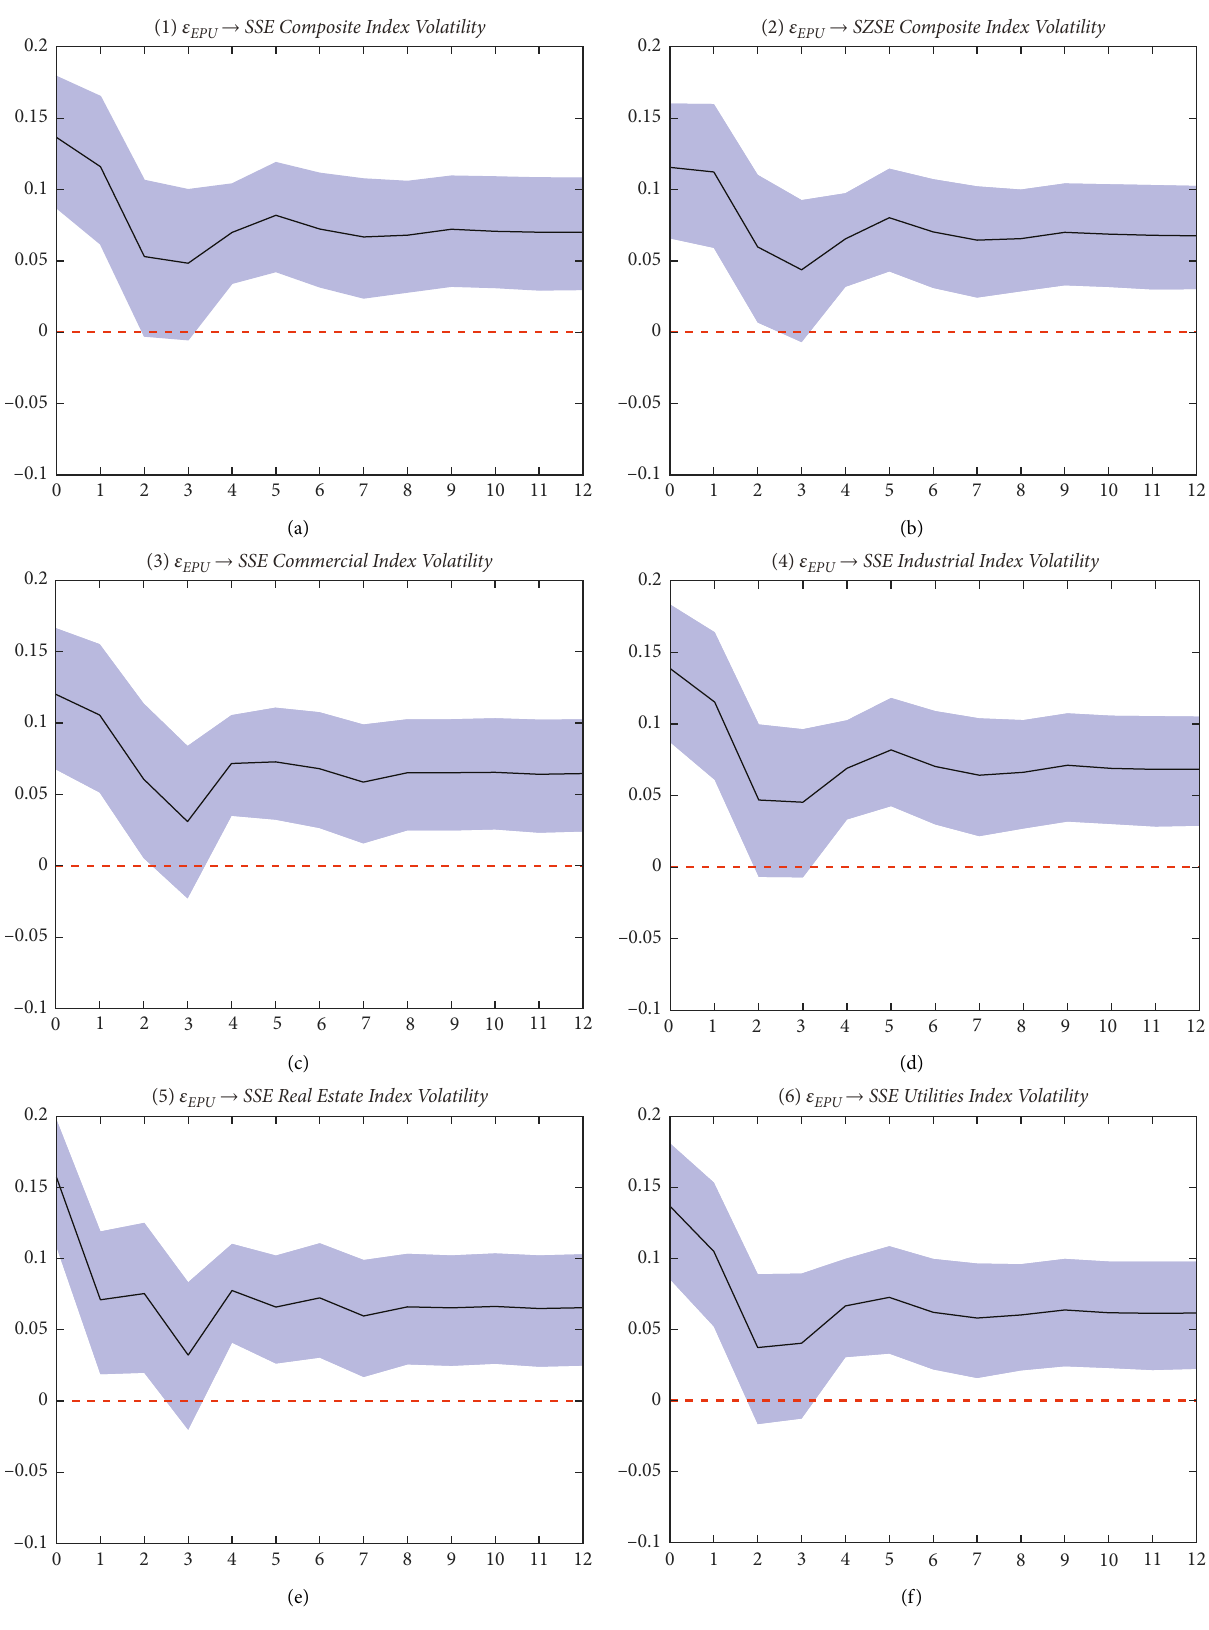
Figure 5: Cumulative impulse response of different stock volatility returns to EPU shocks. Note: the solid black lines denote the median impulse response, the shaded region represents 68% error bands, and each period is a